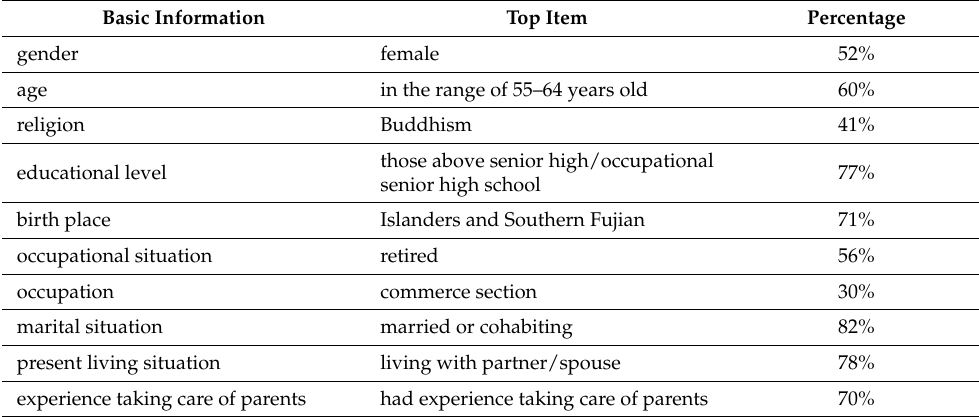
Table 1. Profile information of the